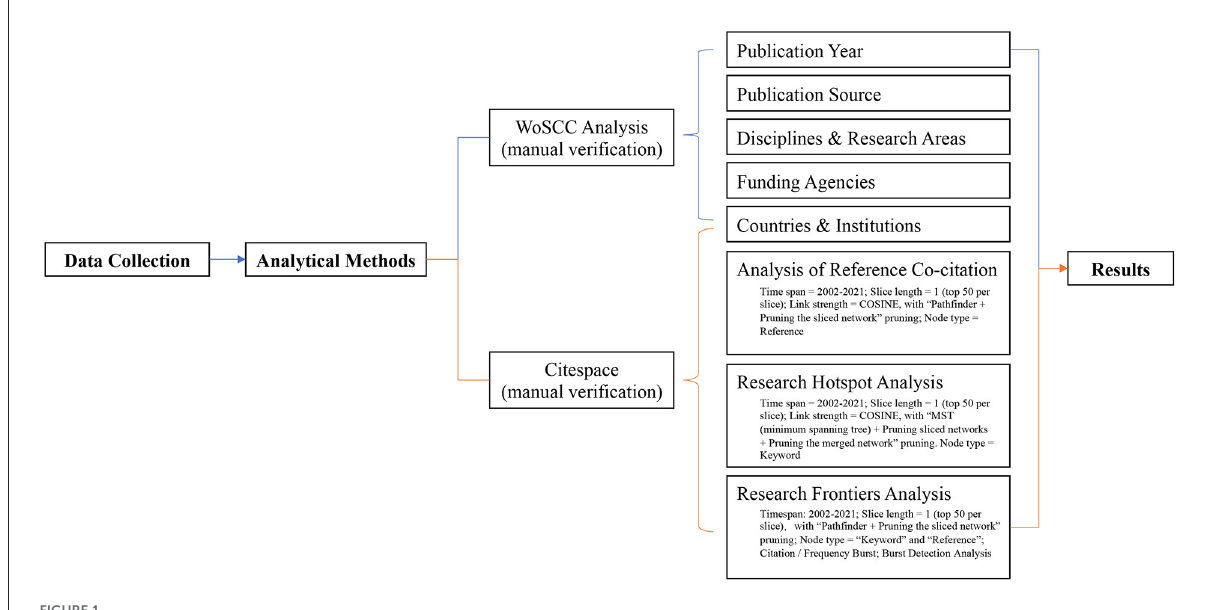
FIGURE1 Flow chart of analytical methods.